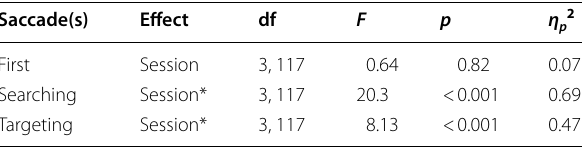
Table 5 Results of analyses on raw value saccade